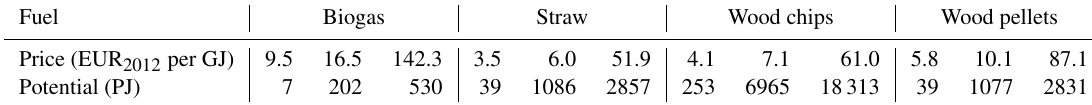
Table 1. Aggregated biofuel potentials and corresponding prices for the countries in focus (the UK, NL, DK, BE, DE and NO); each fuel is modelled with a stepwise price function with three levels. Data gathered as shown in Gea-Bermudez et al. (2019a).